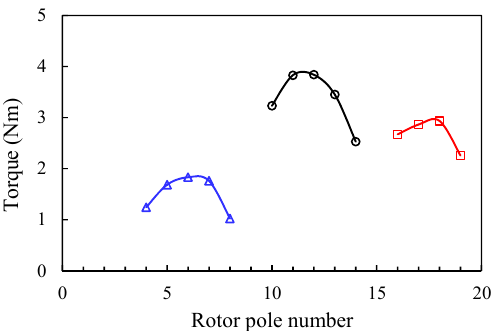
Figure 11. FE-predicted normalized torque of 6-stator-slot PS-SF-HMMMs with respect to rotor pole numbers.